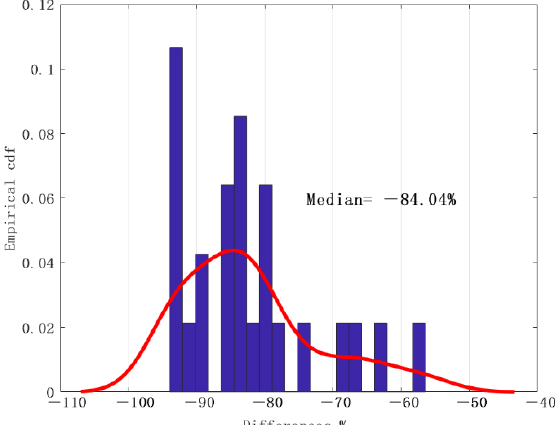
Figure 3. Histogram for relative change of CSES Ne corresponding to QJISR Ne. The Y axis represents empirical cumulative distribution function (cdf).